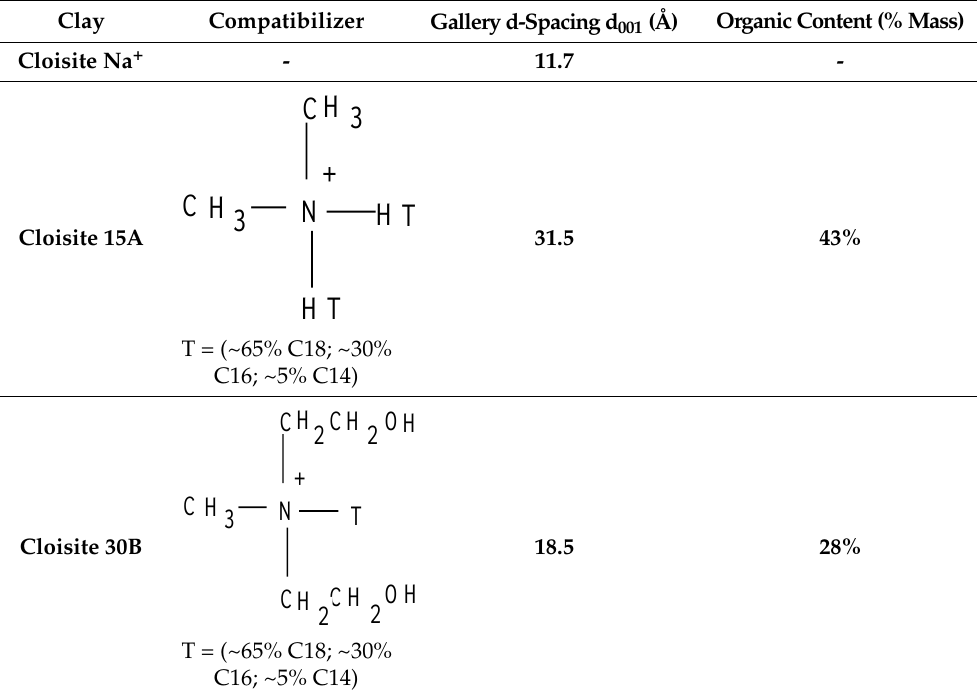
Table 1. Specifications of MMT clays.